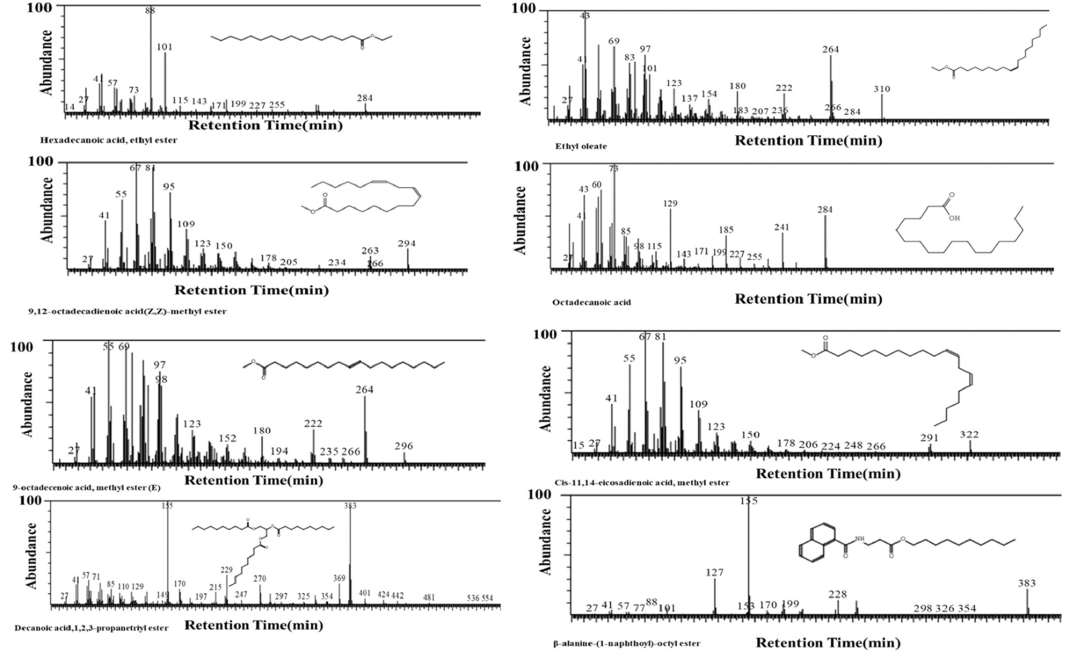
Figure 4. GCMS analysis of N. sativa seed extract.